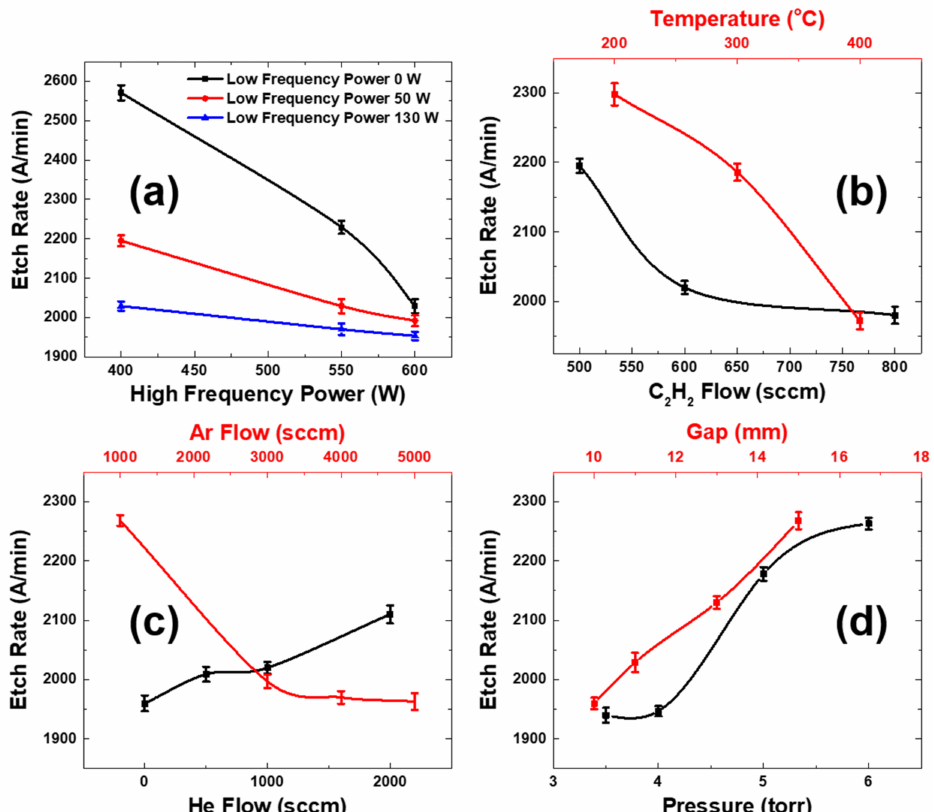
Figure 5. Dependence of ACHM ER on ( a ) HRF and LRF power, ( b ) temperature and C 2 H 2 flow, ( c ) Ar and He flow, and ( d ) gap and